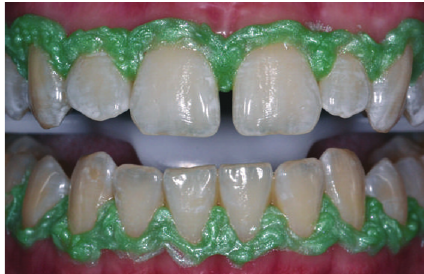
Figure 2: Gingival barrier properly applied and light-cured.